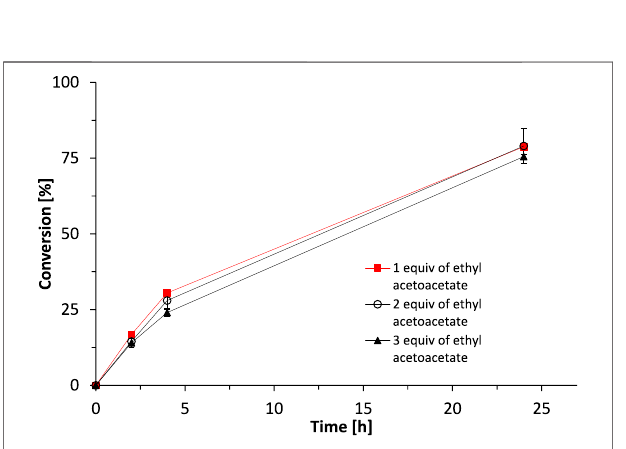
Frontiers in Catalysis |